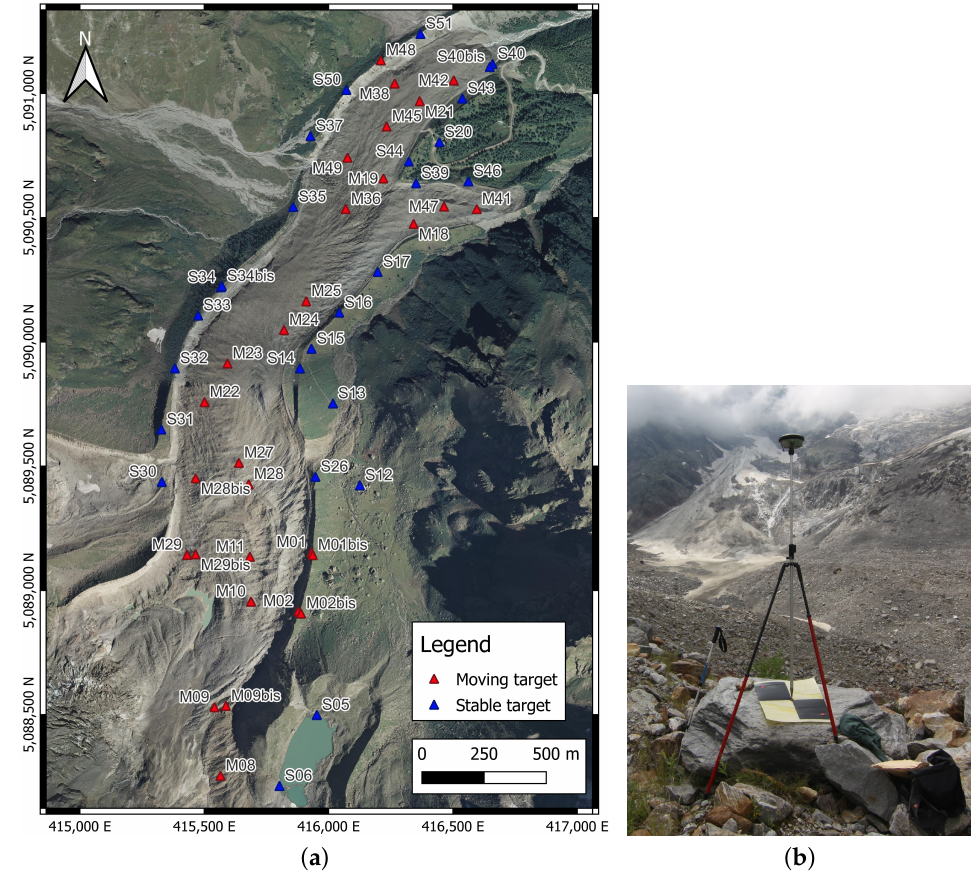
Figure 2. ( a ) Location of the targets used for the photogrammetric surveys. For each year, a subset of the targets was used as GCPs, while the remaining as CPs; ( b ) lan example of a photogrammetric target deployed over the glacier